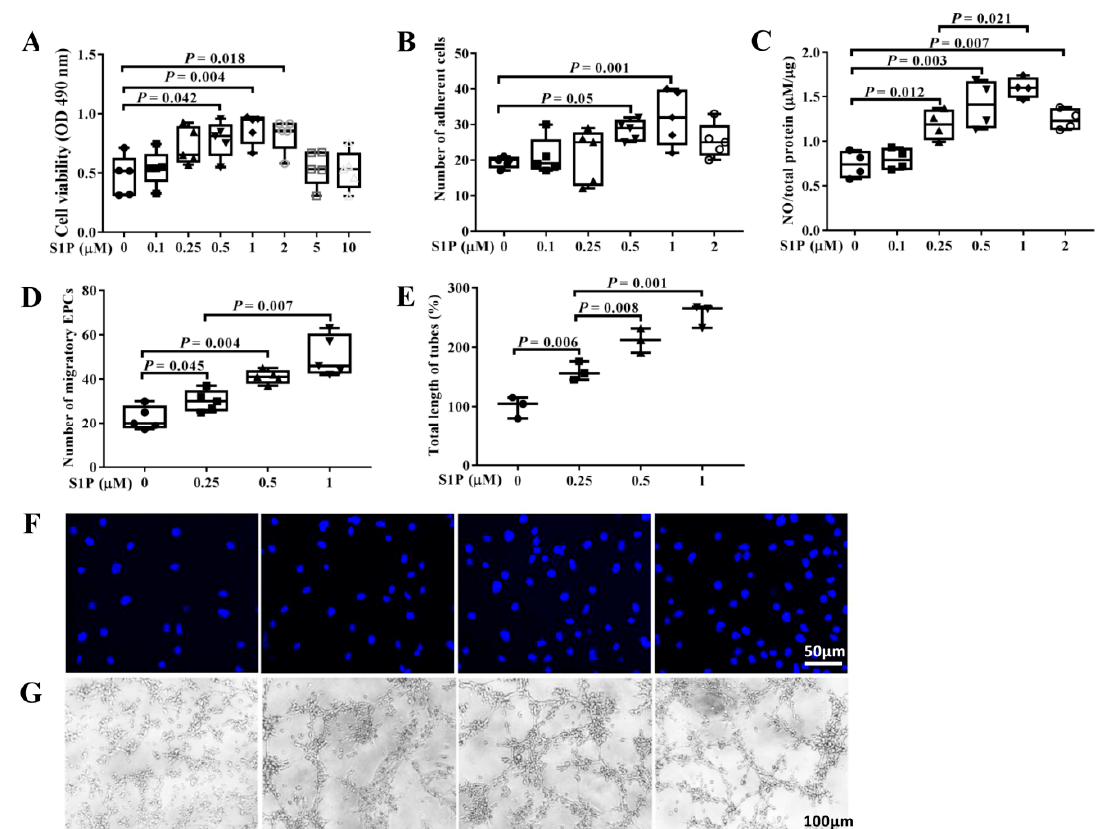
Figure 2. Sphingosine-1-phosphate (S1P) improves the biological features of EPCs. The EGM-2MV medium was replaced with M199 with 3% FBS before EPCs were subjected to the treatment of S1P for 24 h at 37 ◦ C with 5% CO 2 . ( A ) Cell viability of EPCs treated with S1P (0–10 µ M); ( B ) number of adherent EPCs treated with S1P (0–2 µ M); ( C ) ratio of NO to total protein in medium after EPCs were treated with S1P (0–2 µ M); ( D ) number of migratory EPCs in 5 random field of views after treatment with S1P (0–1 µ M); ( E ) average total length of complete tubes after treatment with S1P (0–1 µ M); ( F ) representative micrograph of migratory EPCs after treatment with S1P (0–1 µ M) ( × 100, corresponding to S1P concentration at 0, 0.25, 0.5, and 1 µ M from left to right, respectively); ( G ) representative micrograph of complete tubes ( × 40, corresponding to S1P concentration at 0, 0.25, 0.5, and 1 µ M from left to right, respectively).